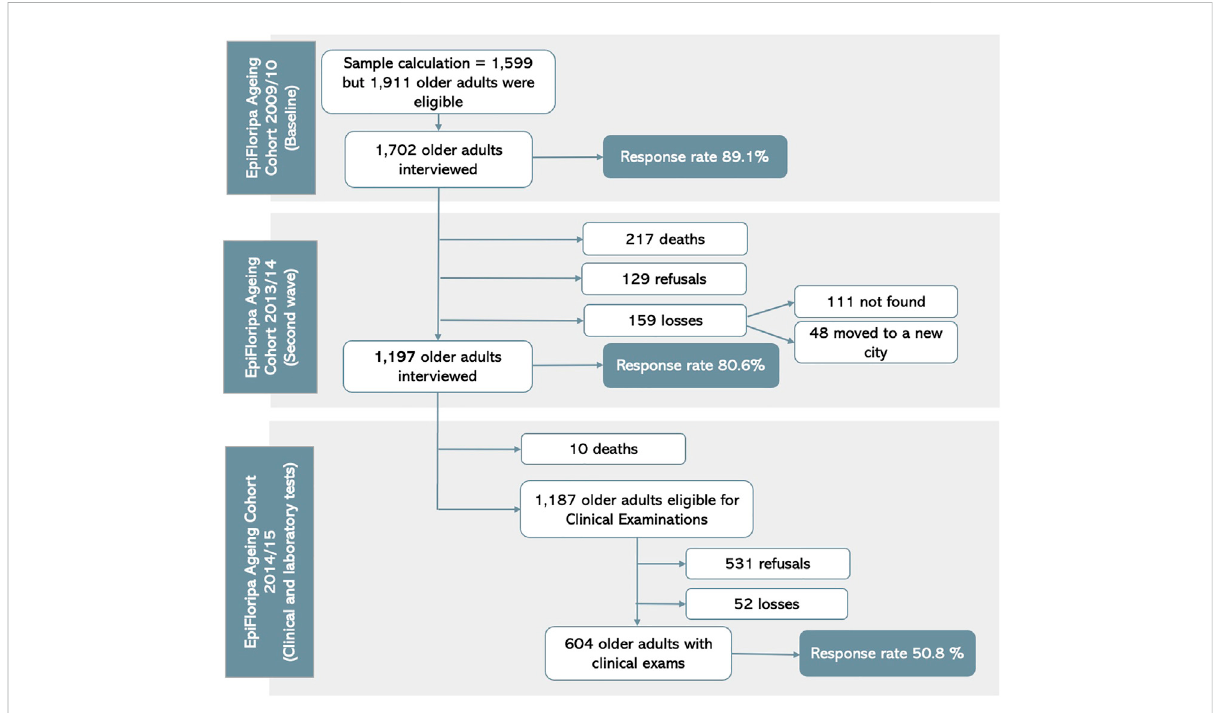
FIGURE 1 Flowchart of the EpiFloripa Aging Cohort Study, waves 1 and 2 (d ’ Orsi et al.,